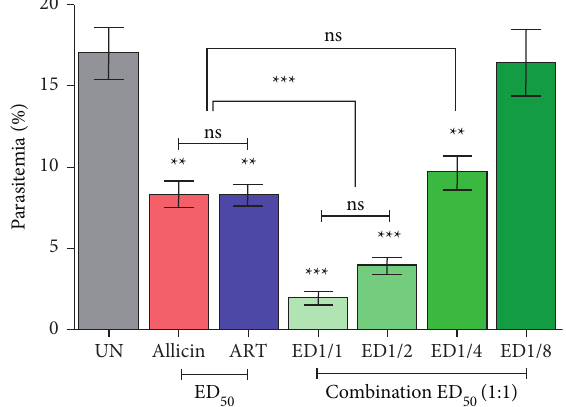
Figure 2: Effect of combination treatment on PbANKA infection in mice. Groups of Balb/c mice were inoculated with 1 × 10 7 par- asitized erythrocytes of PbANKA by IP injection and given orally with combination treatment between allicin and ART at the doses of their respective ED 50 and fixed ratio (1:1) of their respective ED50 of 1/2, 1/4, and 1/8 for 4 consecutive days. Parasitemia was estimated. UN, untreated control. ∗∗ P < 0 . 01 and ∗∗∗ P < 0 . 001 compared to UN.